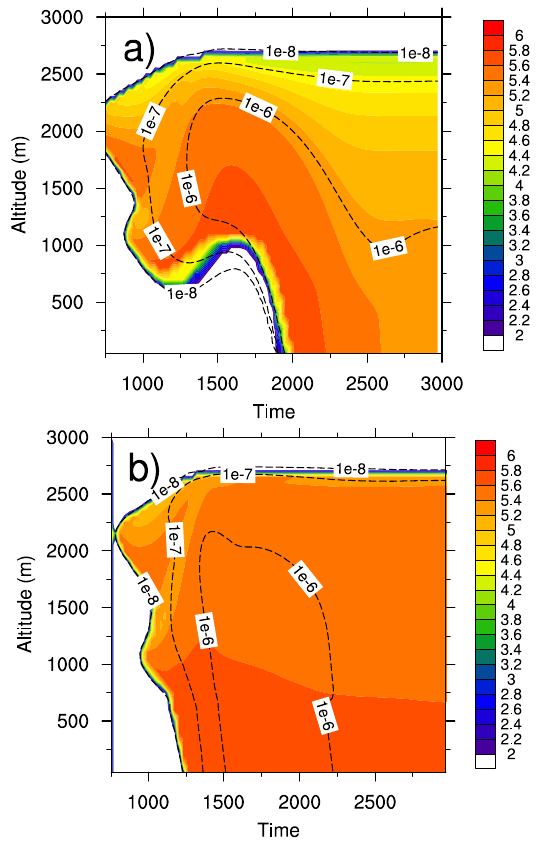
Figure 5. HaRP case: time evolution of vertical profiles at the centre of the cloud cell for pH 3 Fig. 5. HaRP case – time evolution of vertical profiles at the centre of the cloud cell for pH value in rainwater: (a) using the Kessler value in rainwater: (a) using the Kessler scheme, and (b) using the C2R2 scheme. The rain 4 scheme, and (b) using the C2R2 scheme. The rain liquid water con- liquid water content (vol/vol) is superimposed as isolines. 5 tent (volvol − 1 ) is superimposed as isolines.